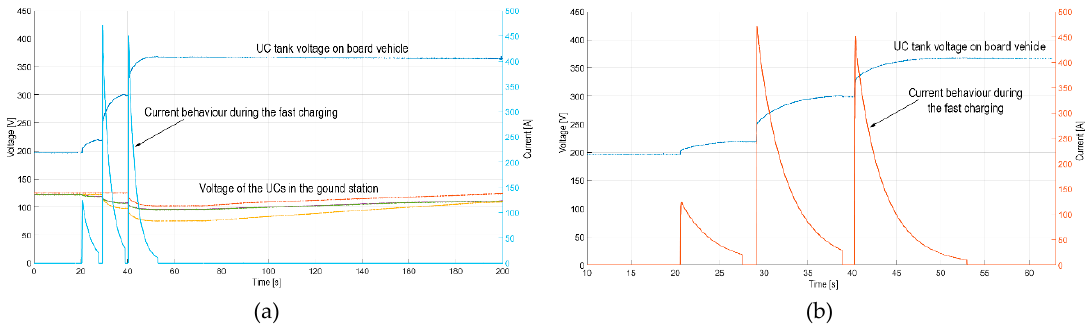
Table 3. Comparison of 1 and 3 step recharge.